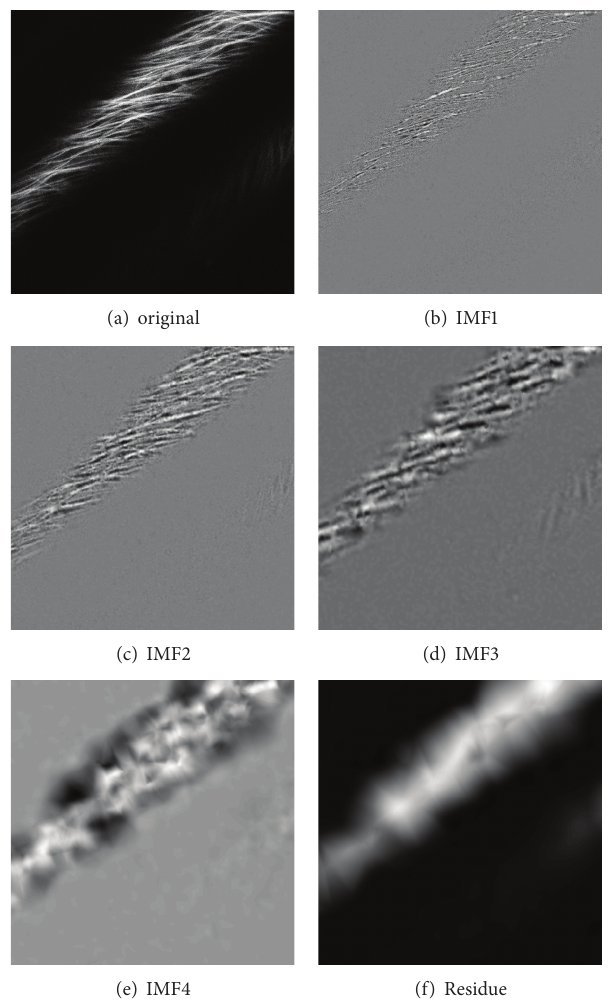
Figure 2: The image of plant microtubules decomposed by the BEMD algorithm.